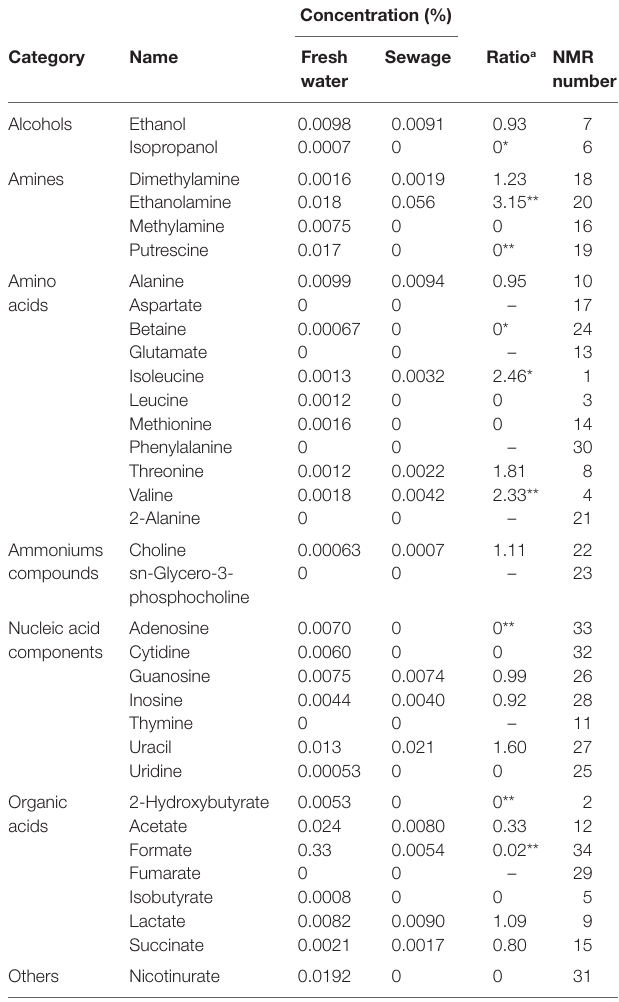
TaBle 3 | intracellular metabolites information table of S. putrefaciens. concentration